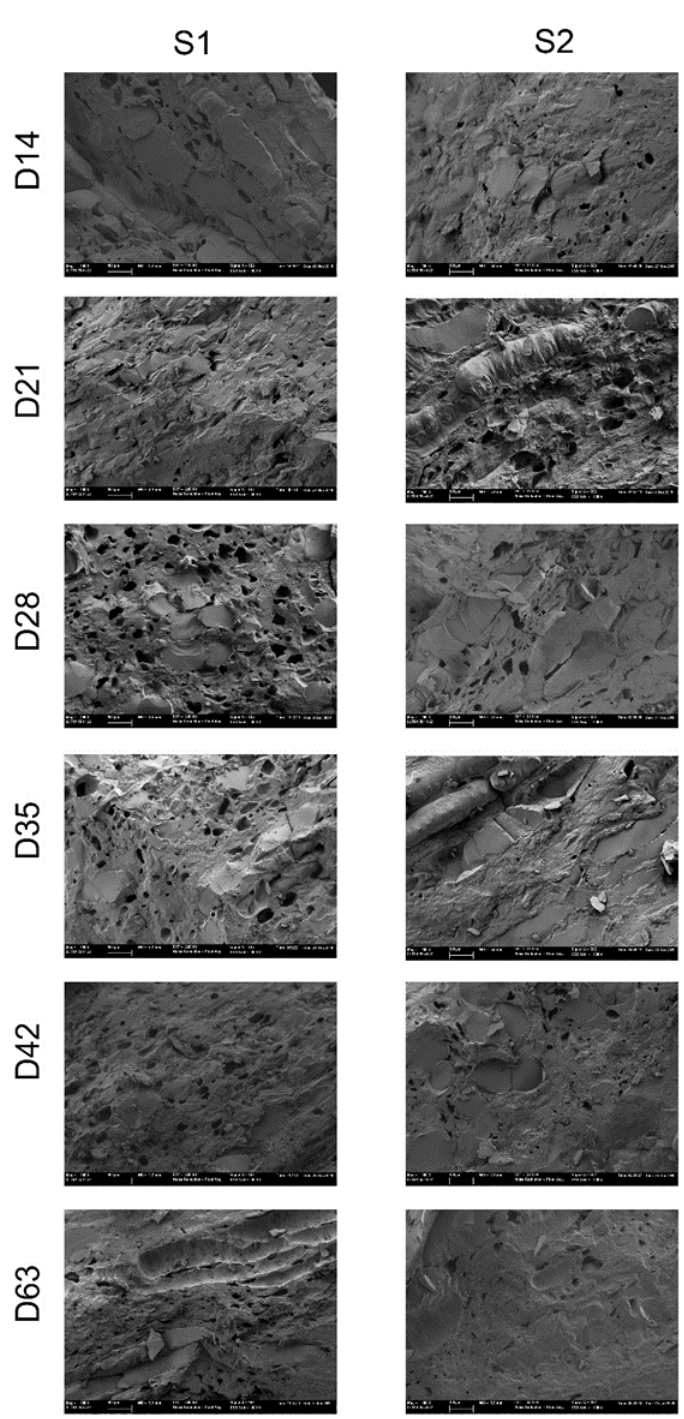
Figure 8. External flesh structure by the Cryo-field emission scanning electron microscopy technique of persimmon cv. Rojo Brillante in two maturity stages (S1 and S2) submitted to drying up to 63 days